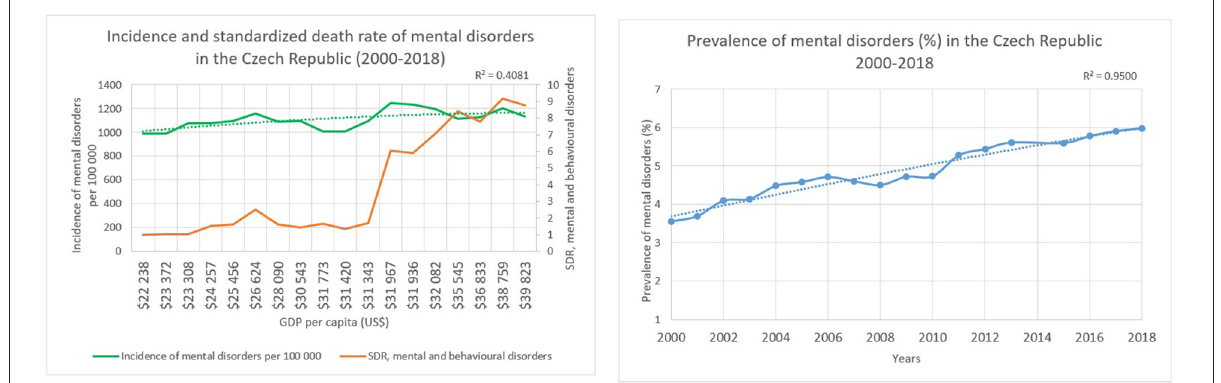
FIGURE2 Characteristics of the Czech Republic.